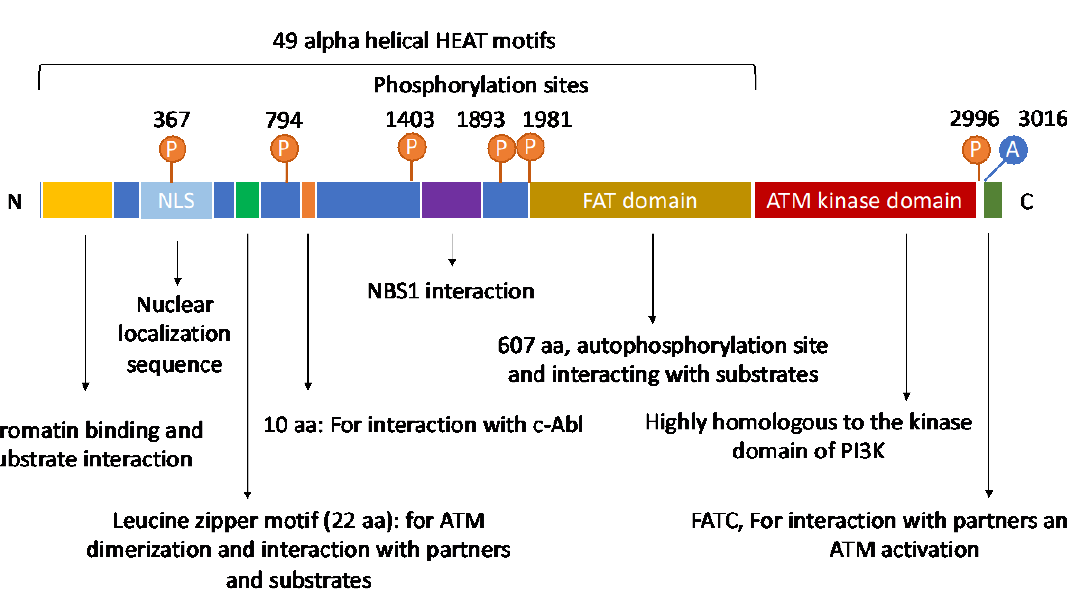
Figure 1. Human ATM’s domain map. ATM is a large gene with 66 exons and consists of multiple domains that allow its protein to directly interact with numerous regulators, partners, and downstream targets. In its N terminus, ATM contains a Nuclear Localization Signal that enables its nuclear translocation. ATM also uses its N-terminus for interacting with chromatin, substrates and partners, for instance, p53, LKB1, NBS1, among others. The putative leucine zipper motif on ATM N-terminus is documented to be essential for its dimerization and interaction with other partners or substrates. On its C-terminus, ATM has a FAT (FRAP, ATM and TRRAP proteins) domain which contains autophosphorylation sites and is critical for substrate binding. As a kinase, ATM has a serine/threonine kinase domain that is highly homologous to that of the PI3K. At the end of its C-terminus is the FATC domain that is essential for ATM full activation and interactions with partners. Of note, ATM contains multiple important autophosphorylation sites that can substantially affect its functions. For instance, Ser367, Ser1893, Ser1981, and Ser2996 are auto-phosphorylated after irradiation. Thr1885 is not induced by irradiation. In human cells, autophosphorylation on three residues Ser367, Ser1893, Ser1981, and acetylation on Lys3016 have been shown to be important for ATM activation. Aurora B phosphorylates ATM at Ser1403 during mitosis. Importantly, ATM also has 49 α helical HEAT motifs whose name is derived from huntingtin, elongation factor 3, the A subunit of protein phosphatase 2A, and target of rapamycin 1 (TOR1). These motifs serve as scaffolds and are critical for ATM interactions with proteins and DNA.